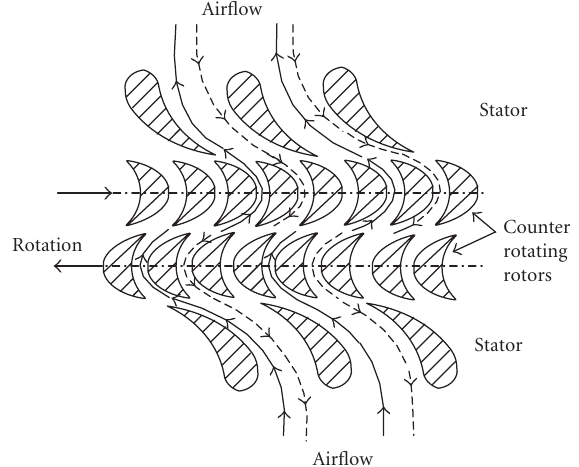
Figure 11: McCormick counterrotating turbine.